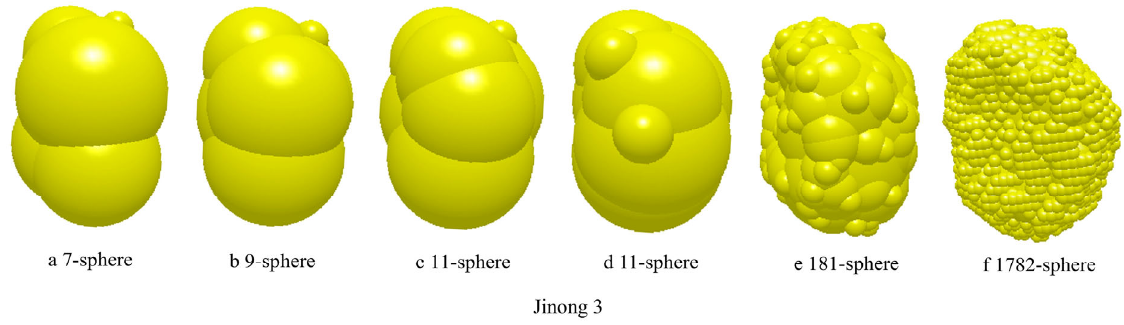
Figure 6. ( a – f ) MS models with different numbers of filing spheres for Jinong 3.